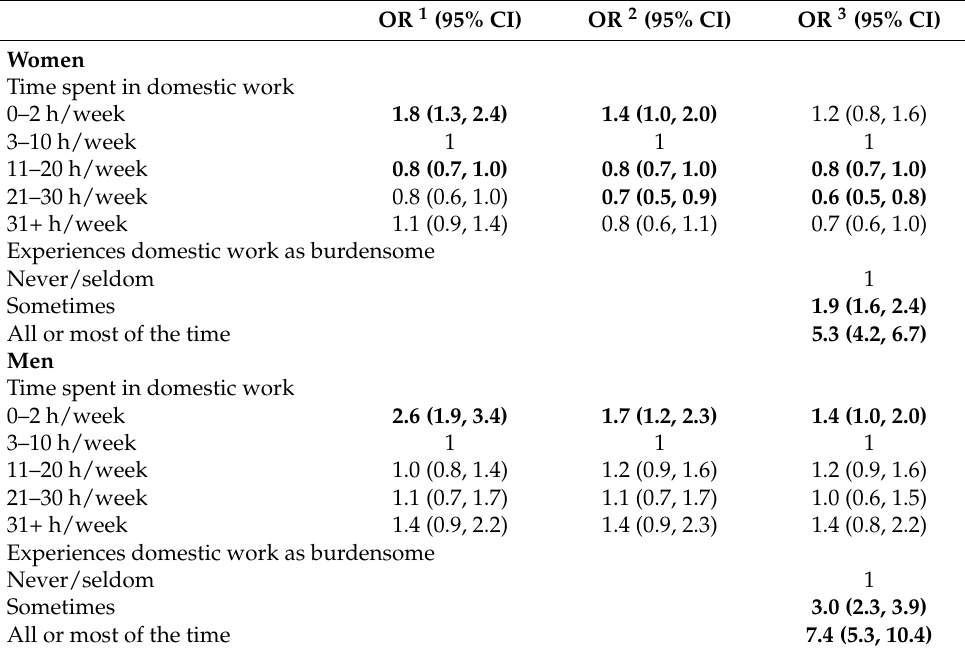
Table 3. Unadjusted and multivariate odds ratios (95% confidence intervals in parentheses) for self-reported diagnosed depression among women and men aged 30–69 years. OR 1 (95% CI) OR 2 (95% CI) OR 3 (95%